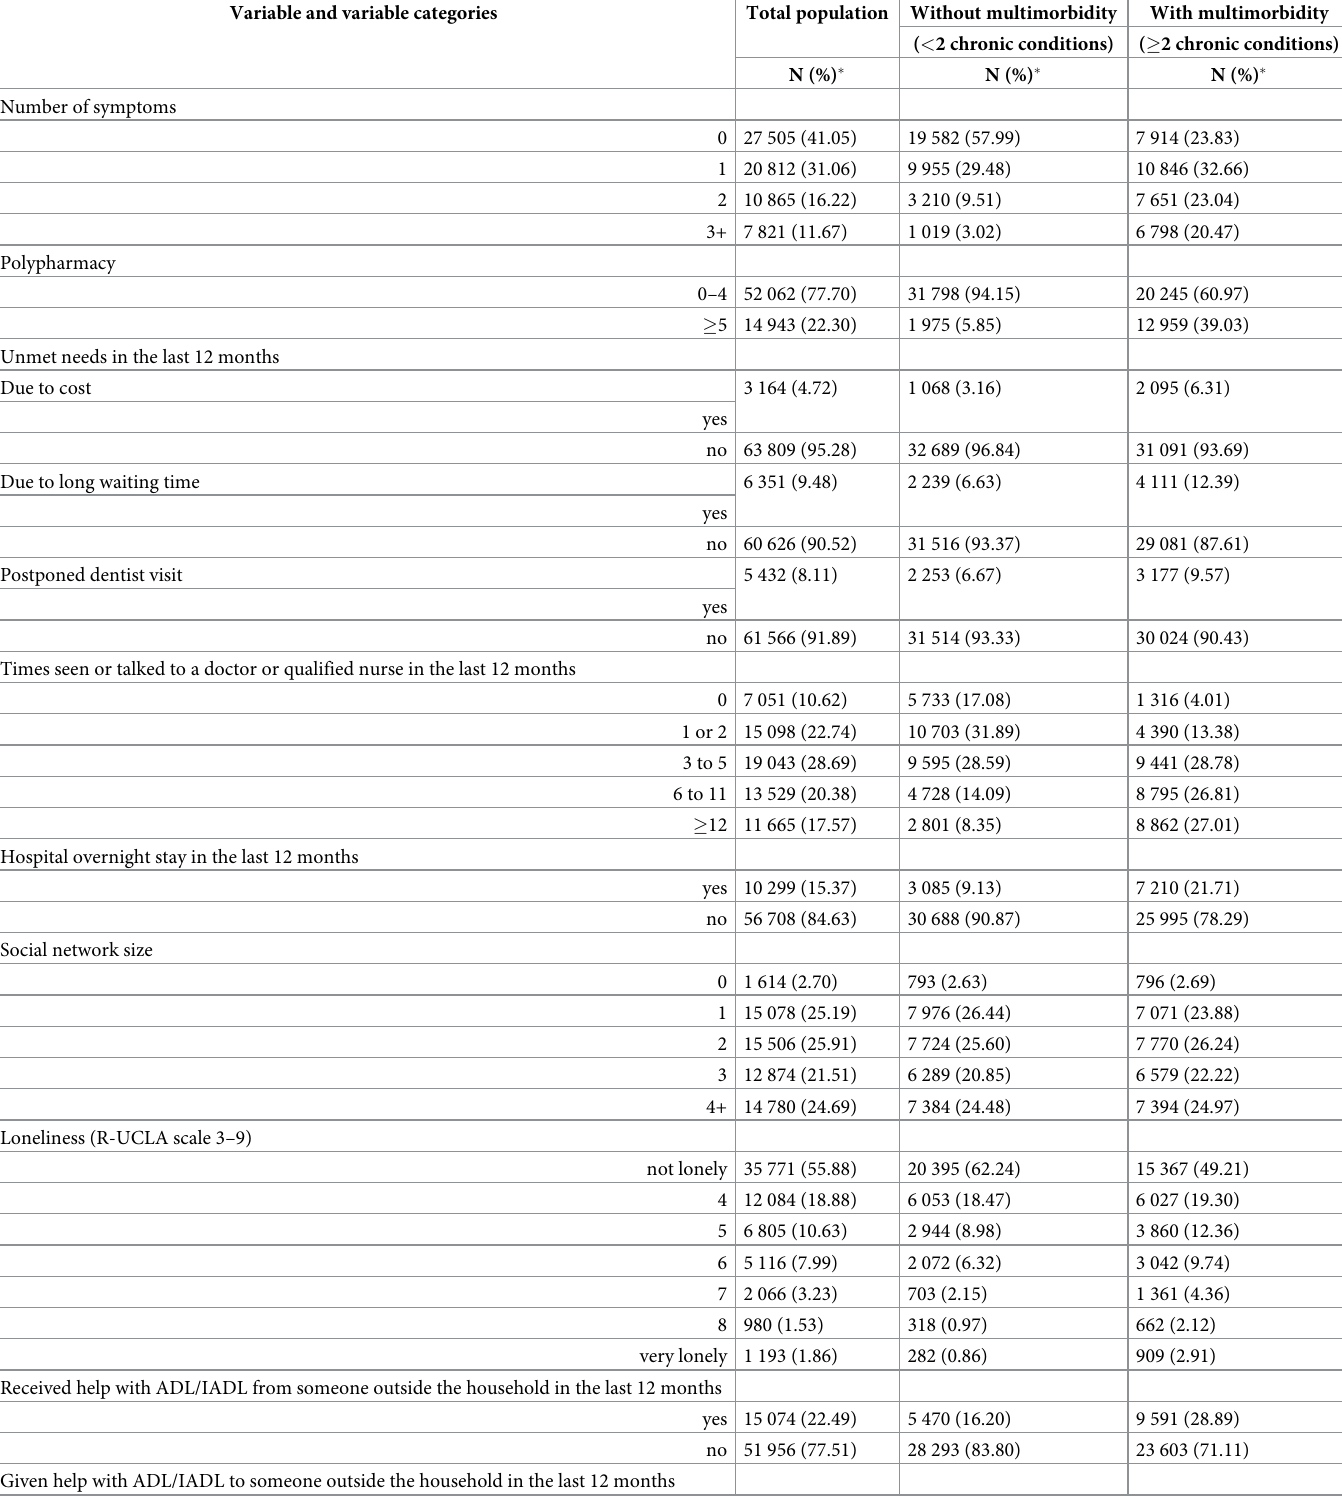
Table 3. Clinical, functional and social factors of the study